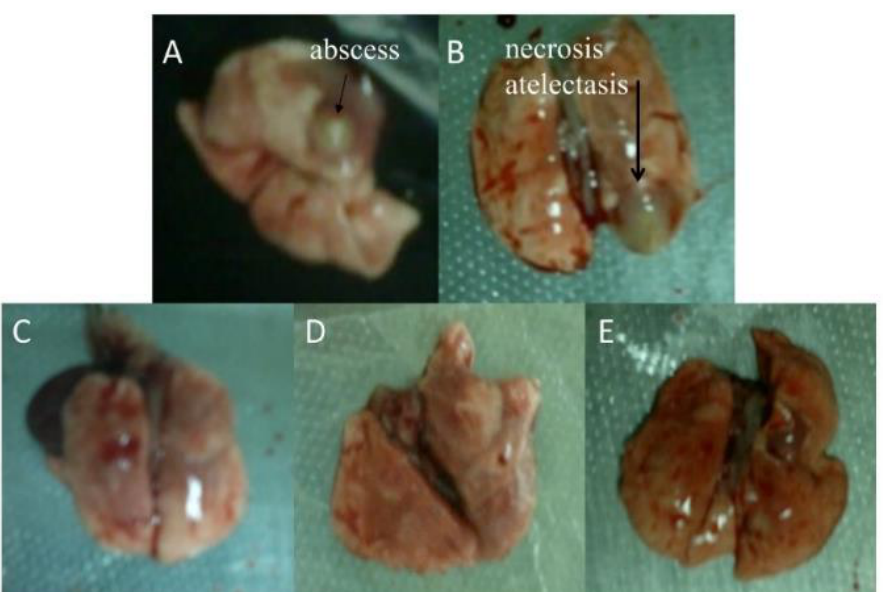
Figure 5. Morphological pathology of rat lungs in different experimental groups. ( A , B ) Panels represent the lungs of rats in Model group. ( C – E ) represent the blank Control group, Cefepime- treated group and Baicalin-treated group. Table 1. Microscopic scoring of the lung pathology in different